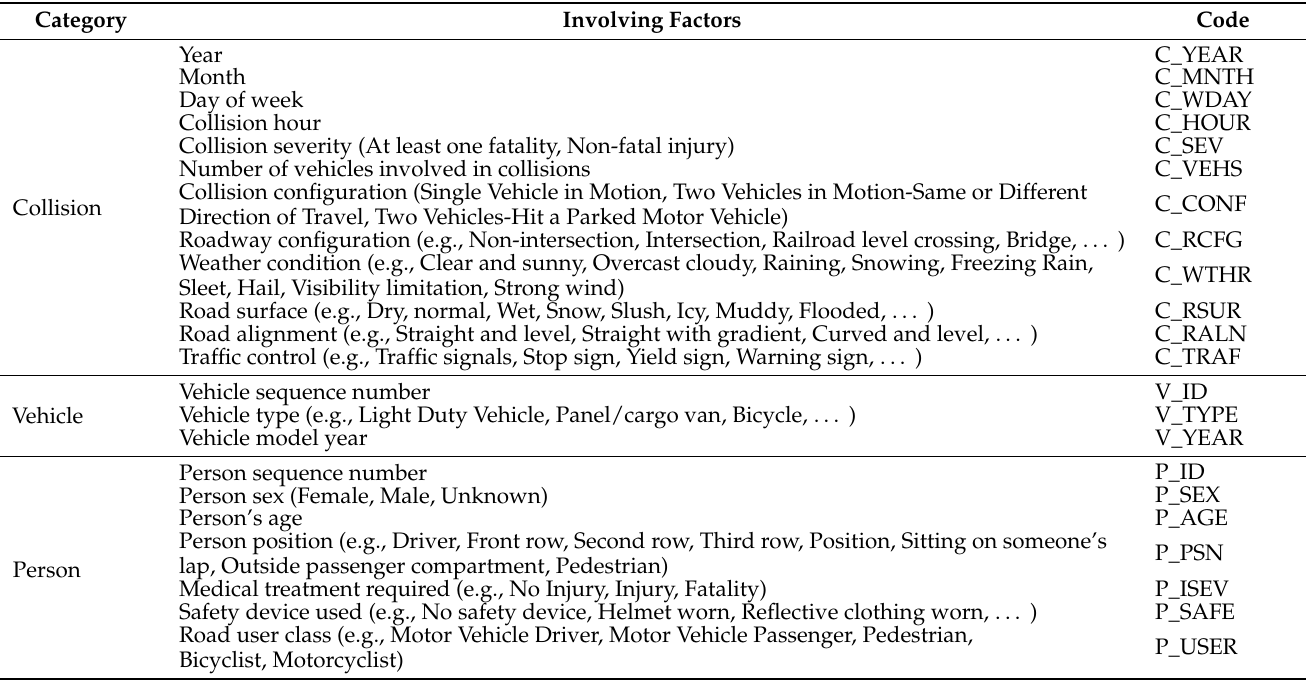
Table 2. Factors in National Collision Database of Canada